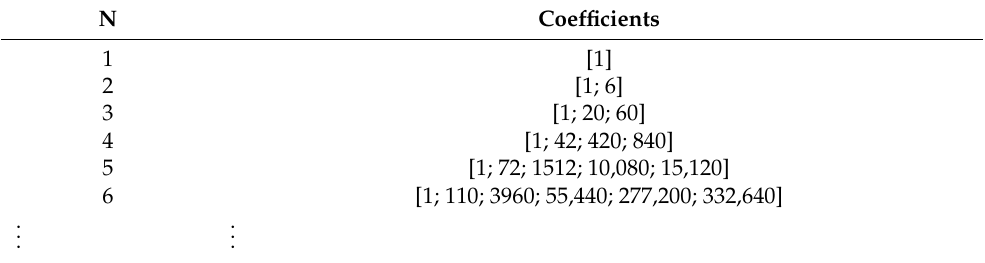
Table 3. Coefficients generated by polynomials whose spatial variables have odd exponents ( q = 0 )